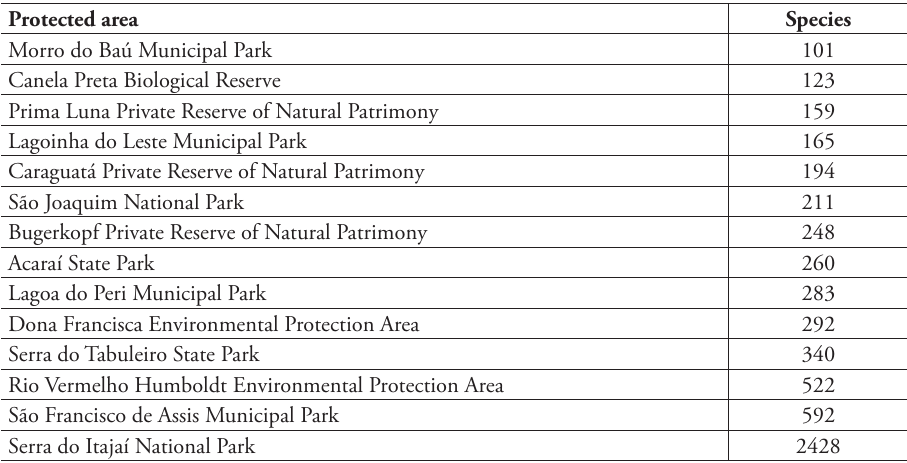
Table 1. Number of specimens from main Conservation Units represented in the herbarium. Protected